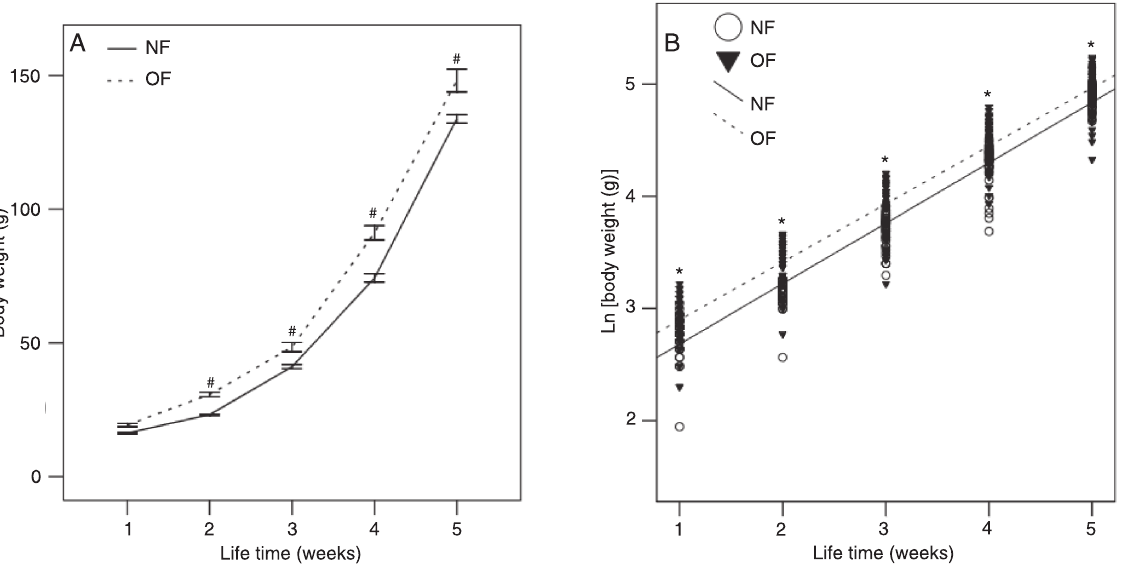
Figure 2. Growth curves during the suckling period (week 0 to 4) and during the first week after weaning. A , Body weights presented on a linear scale. B , Regression curve of natural logarithm (Ln) of body weight. Data are reported as means ± SEM in Panel A. NF = normally fed; OF = overfed. # P < 0.001 [two-way ANOVA for repeated measures (Panel A) and ANOVA for regression (Panel B) fol- lowed by the Tukey post hoc test]. *P < 0.01 OF vs NF.